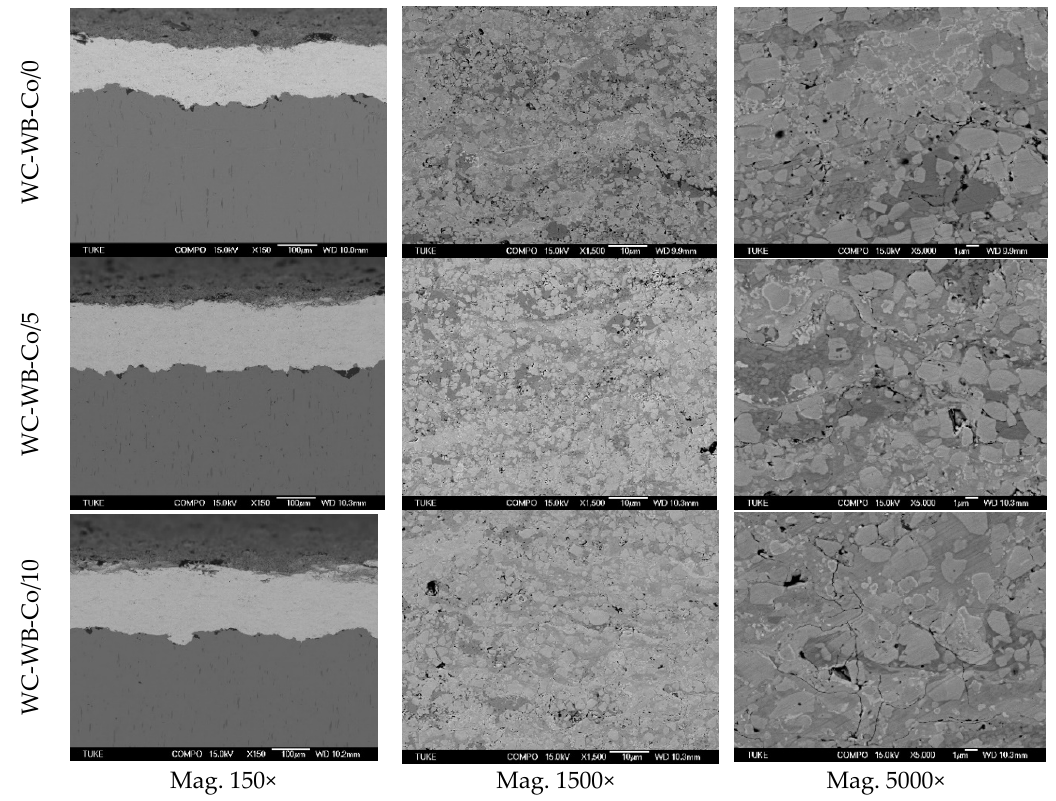
Figure 18. Microstructure of WC ‐ WB ‐ Co coating.